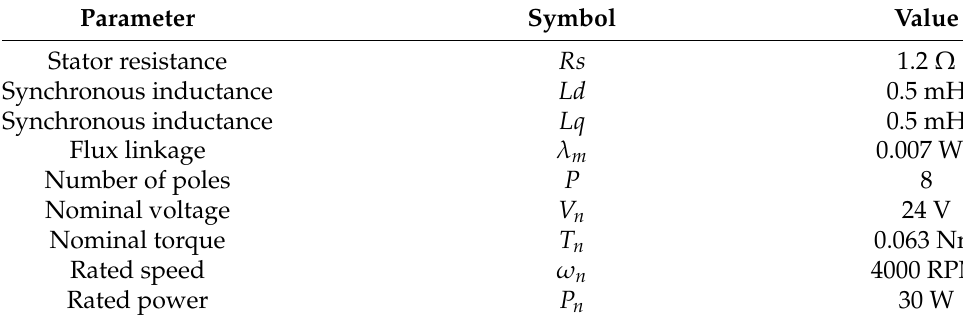
Figure 7. Experimental system configuration. Table 3. PMSM